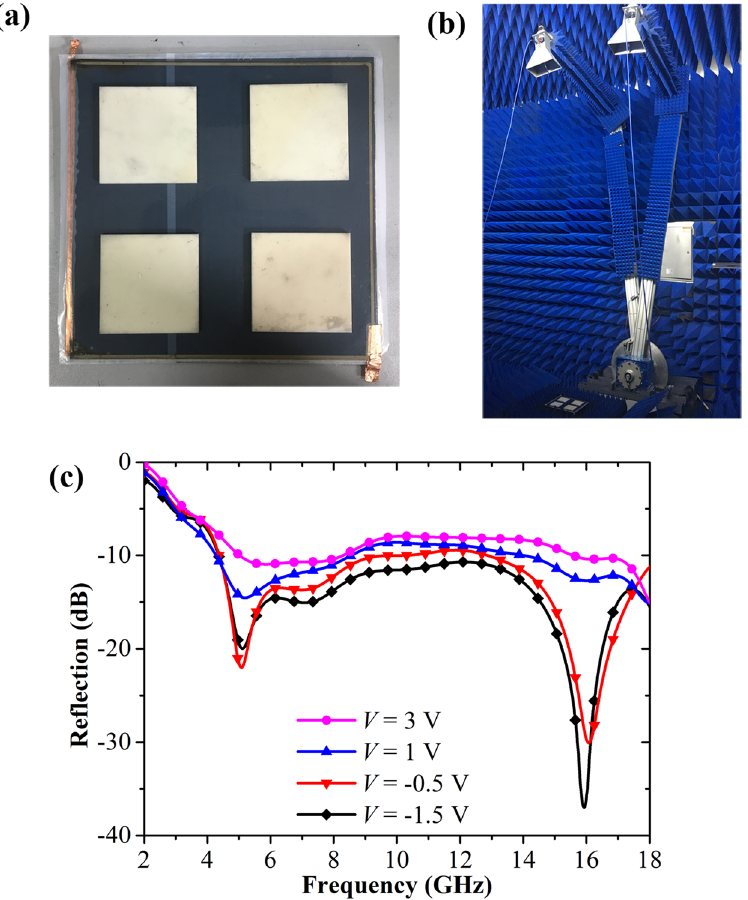
Figure 7. Photograph of measurement setup for the fabricated sample and its corresponding measurement results. ( a ) Photograph of the fabricated sample. ( b ) Photograph of the arch measurement system. ( c ) Measured reflection characteristics of the fabricated sample under normal incidence with the different DC biasing voltages applied on the graphene layer.